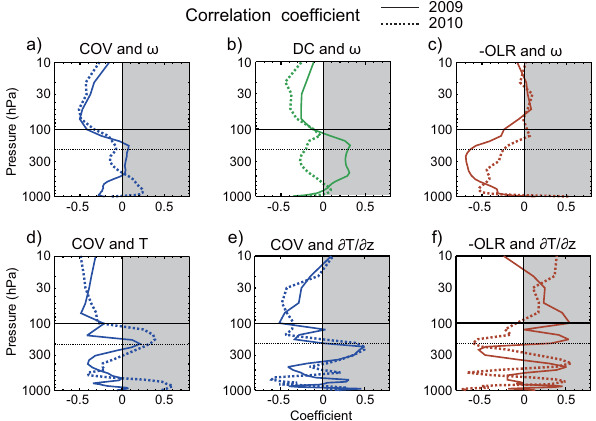
Figure 2. (a) Correlation coefficient between the pressure coordi- nate vertical velocity ( ω ) at each pressure level and the daily convec- tive overshooting occurrence frequency (COV) averaged over the tropics. (b) As for panel (a) but for deep convection (DC). (c) As for (a) but for the correlation coefficient with − OLR. (d) Same as in panel (a) except for COV and temperature at each level. (e) Same as in panel (d) except for COV and vertical temperature gradient at each level. (f) Same as in panel (e) except for − OLR and vertical temperature gradient. Variables were first averaged over 25 ◦ S to 25 ◦ N, and then the correlation was calculated over 31 days centred at the onset day (16 January in 2009 and 20 January in 2010). Solid and dashed lines indicate 2009 and 2010,